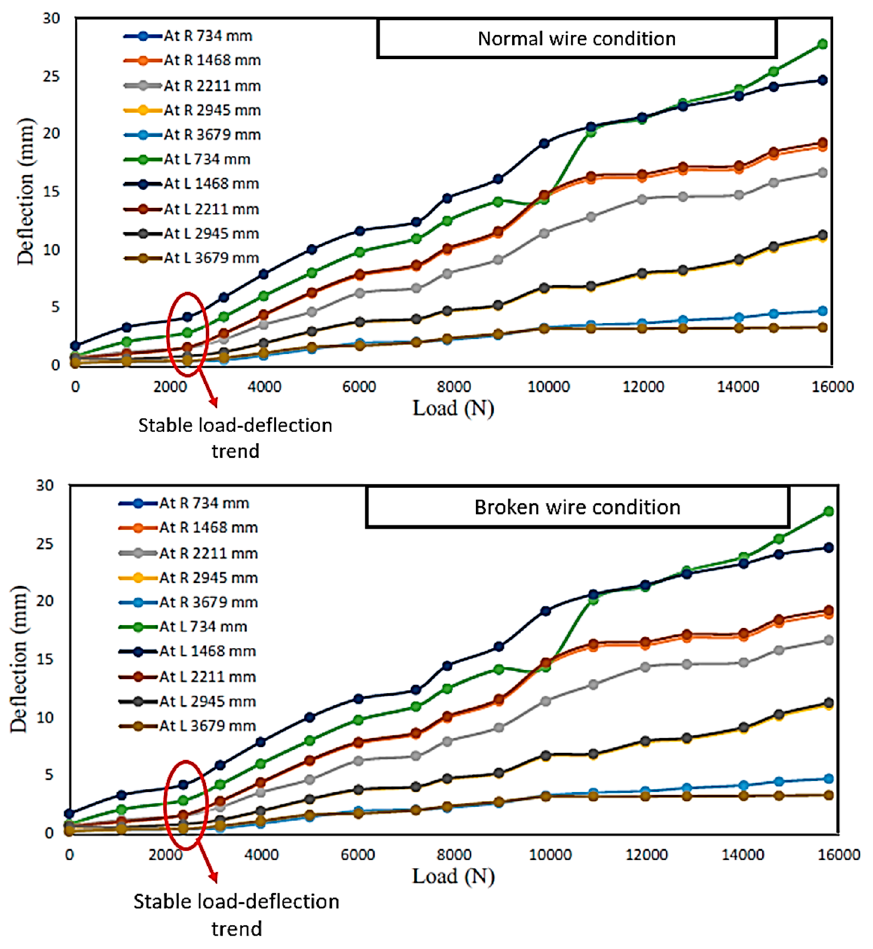
Figure 11. Load–deflection trends of normal and broken wire conditions of wooden cross arm in 132 kV transmission tower [101].